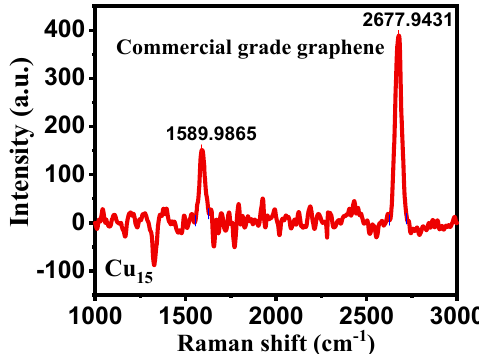
Figure 2. Raman spectra of pristine high − quality graphene.